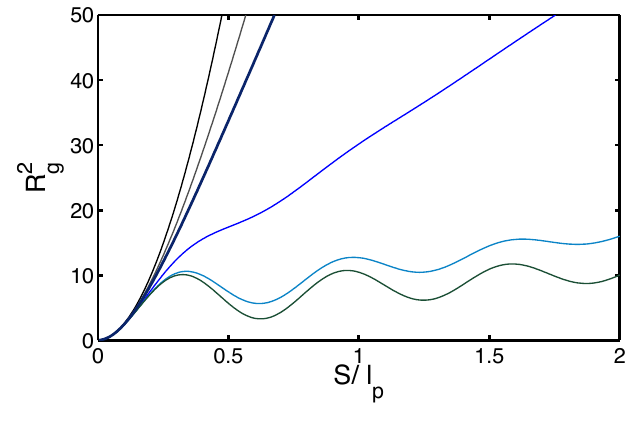
Figure 8. R 2 g ( S ) for ω = 0.01/ b and l p = 1000 b . The Boltzmann weight of a twist kink is e − E . The thin lines are for E = 2,4,6,8 and 10 from top to bottom. The thick line indicate R 2 g with E = − log ( b ω ) ≈ 4.6. Undulations appear for E > − log ( b ω ) .